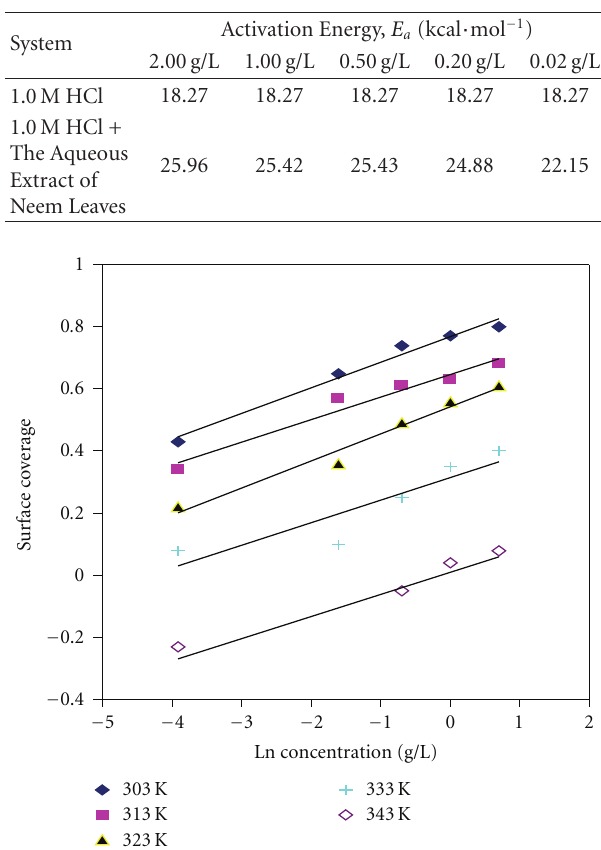
Table 5: The activation energy ( E a ) for the corrosion of carbon steel in 1.0M HCl with and without the aqueous extract of Neem leaves at various concentrations.